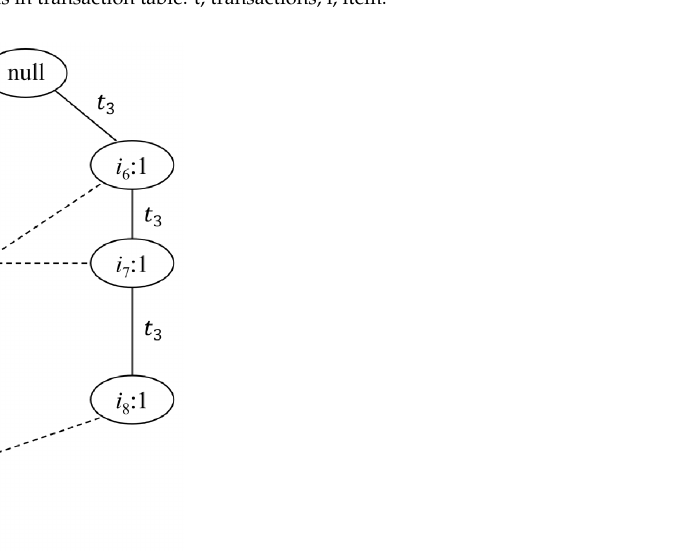
Figure 1. Schematic representation of the frequent pattern growth algorithm with an illustration of fully grown frequent pattern tree using transaction data. t , transactions; i , item.